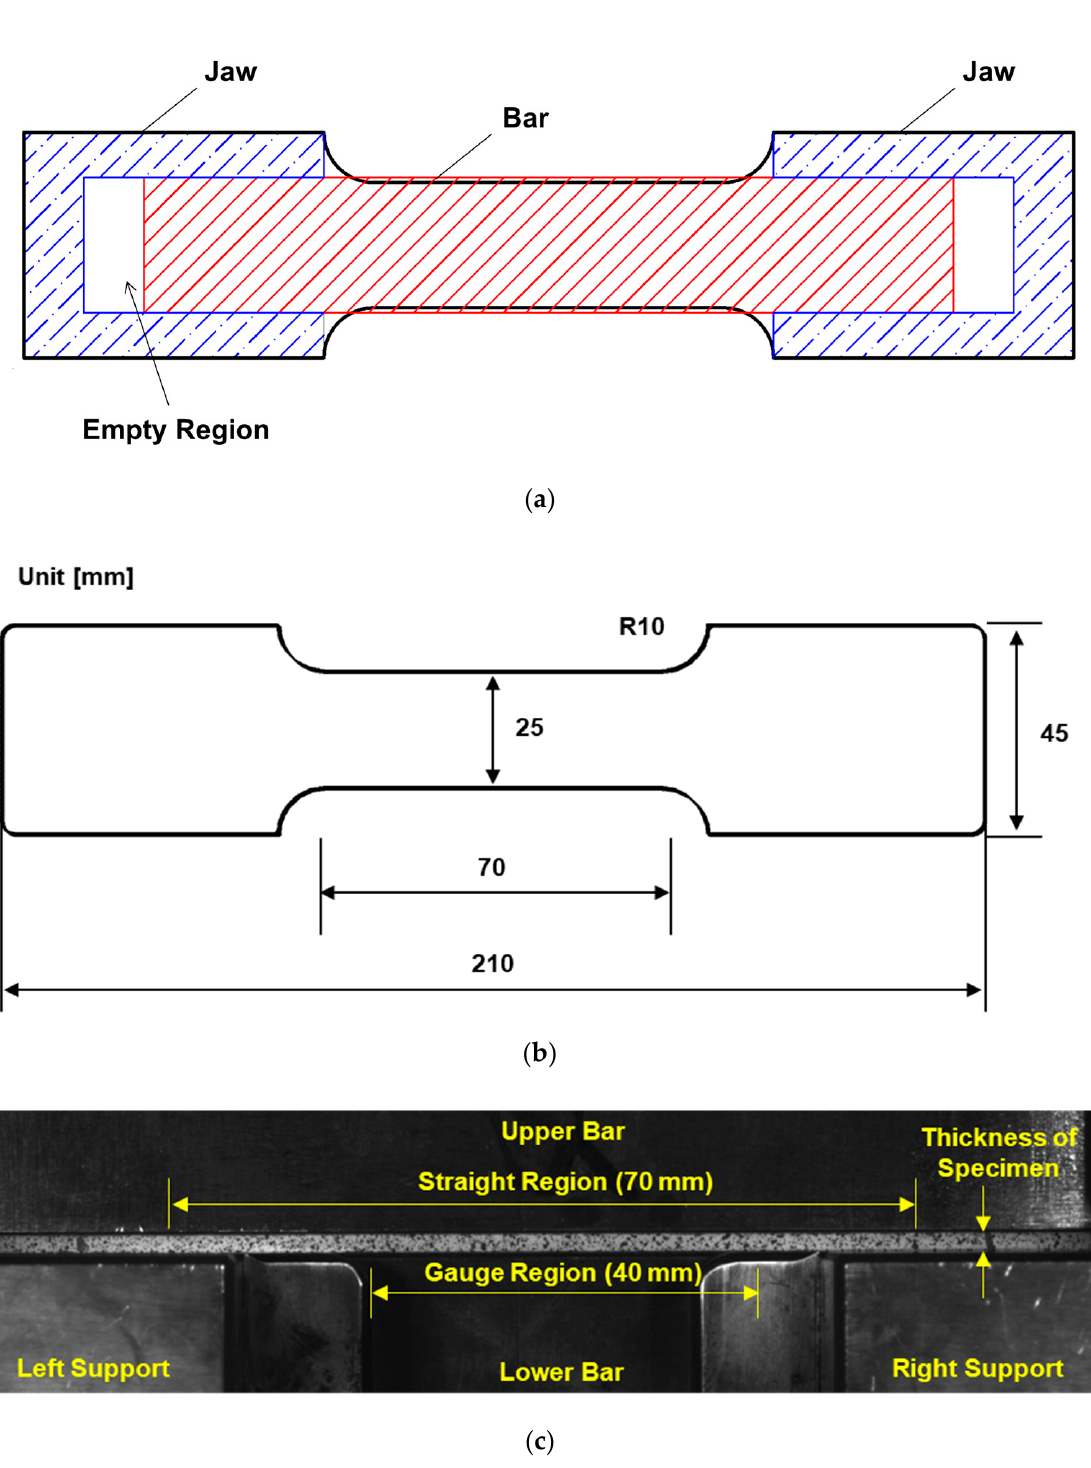
Figure 1. Tension–compression tester: ( a ) the exploded and ( b ) assembled views, and ( c ) the exper ‐ imental setup.